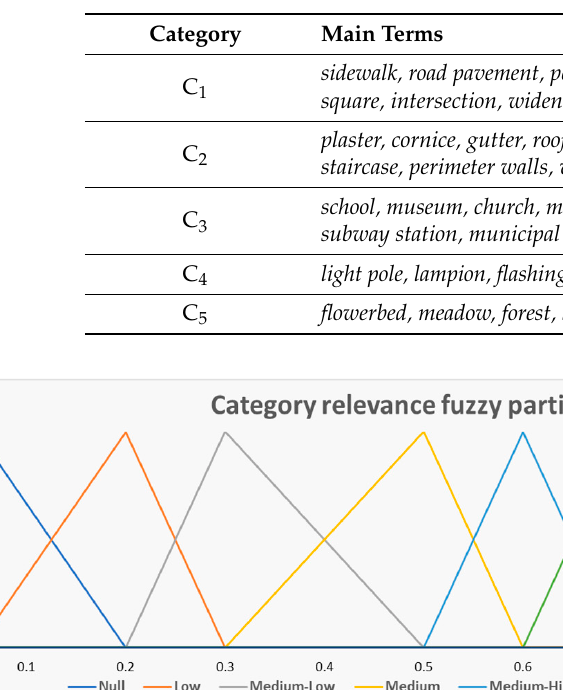
Table 5. Main terms of each category in the dictionary.